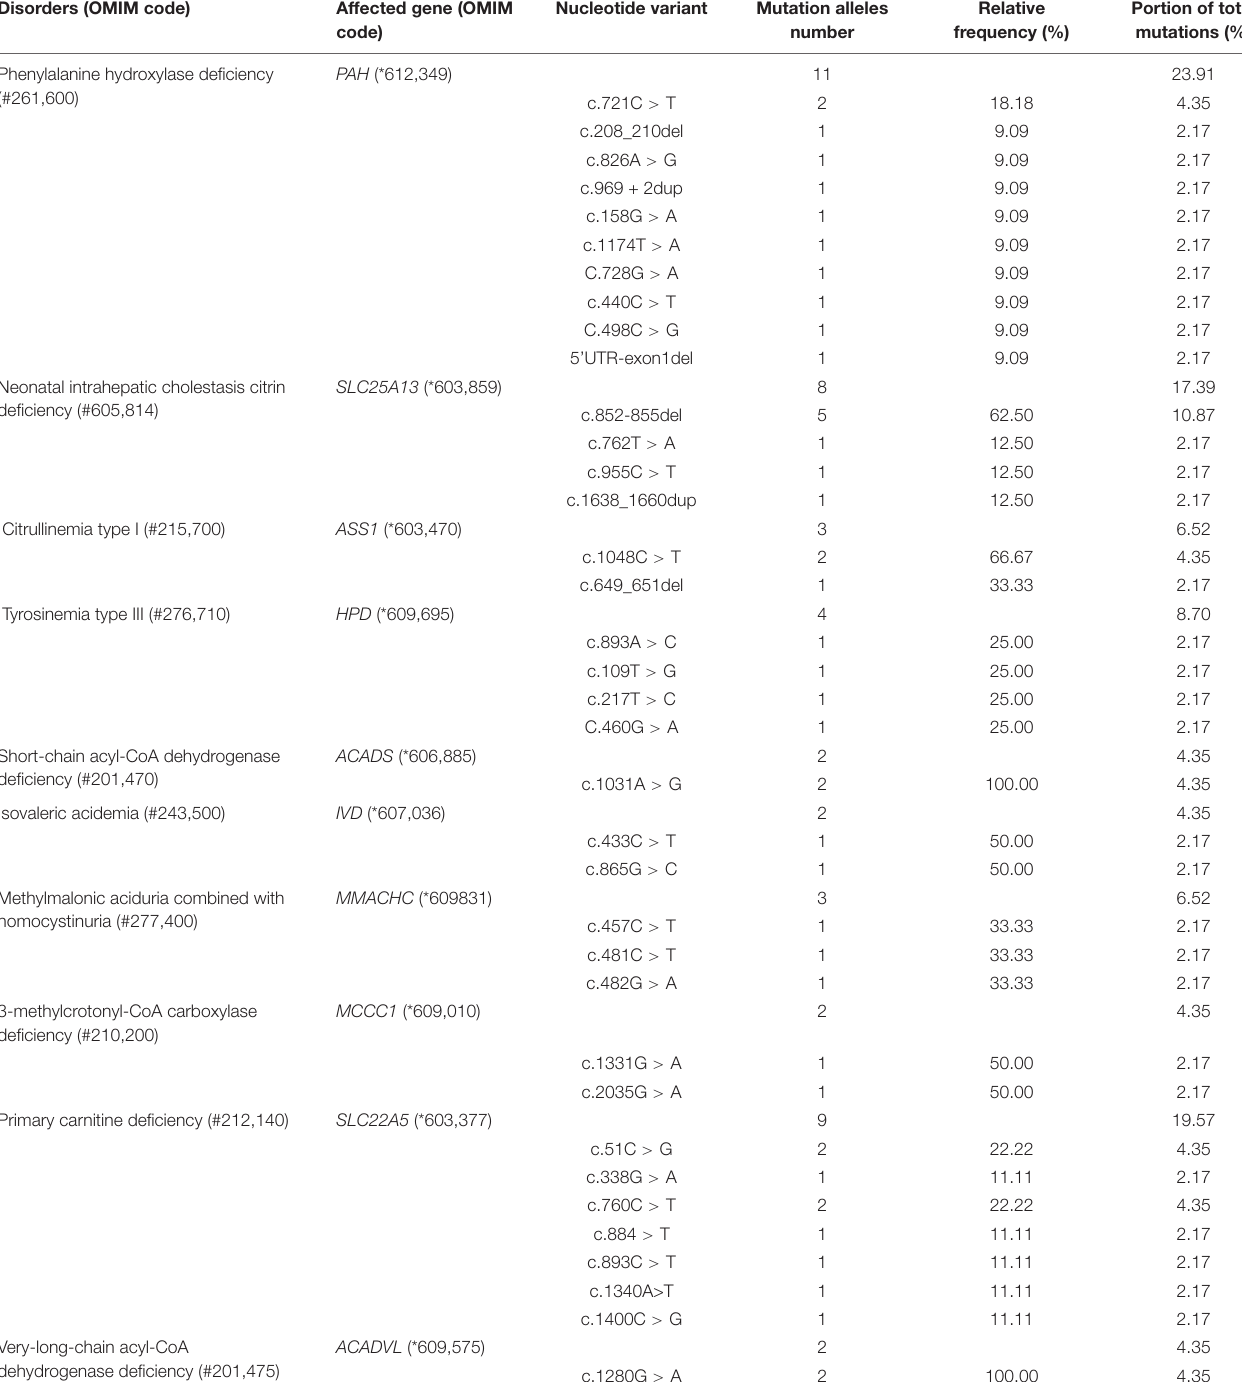
TABLE 4 | Mutations detected in patients with IEMs identified by tandem mass spectrometry (MS/MS). Disorders (OMIM code) Affected gene (OMIM